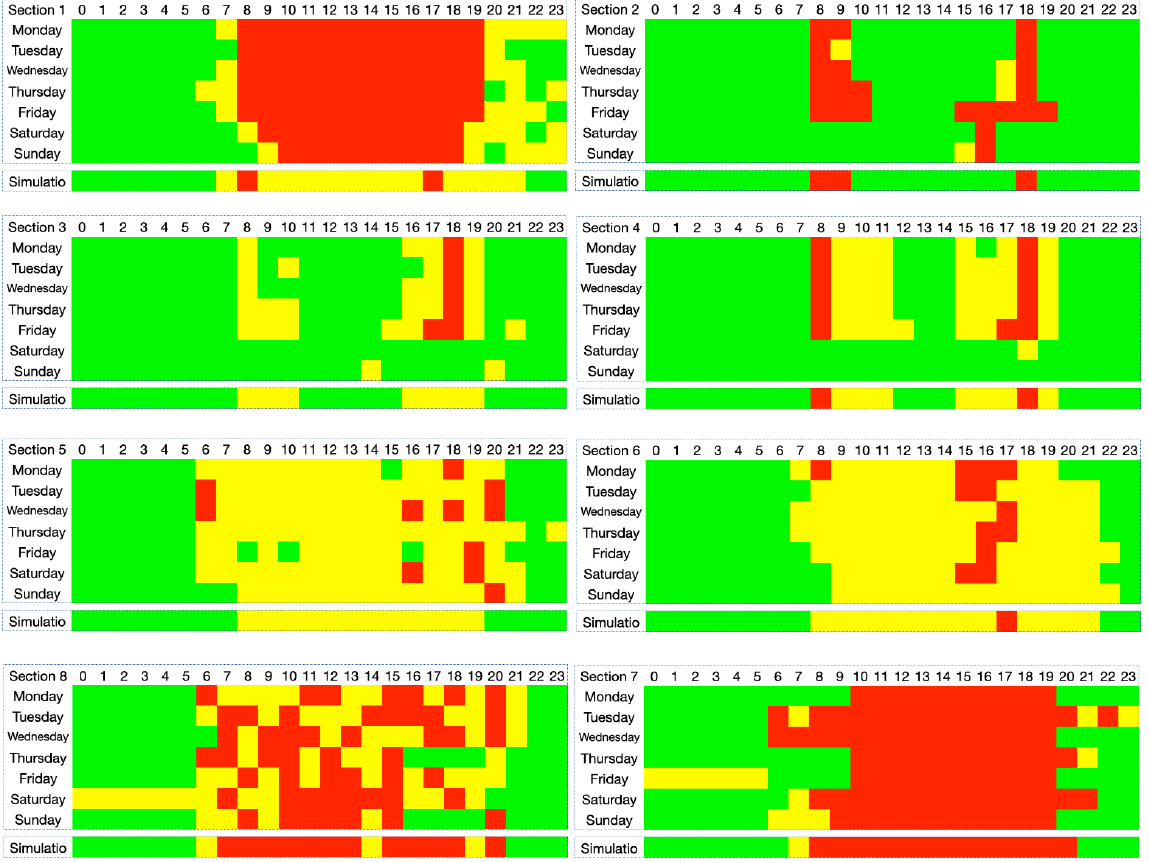
Figure 5. Comparison of simulated traffic and forecasted traffic.